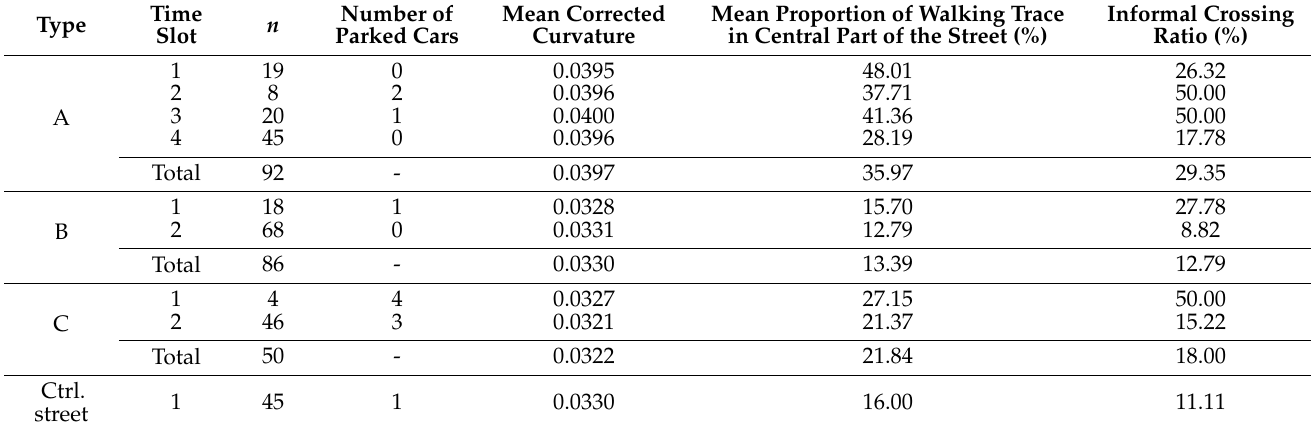
Table 9. Movement patterns by design type and time slot (number of parked